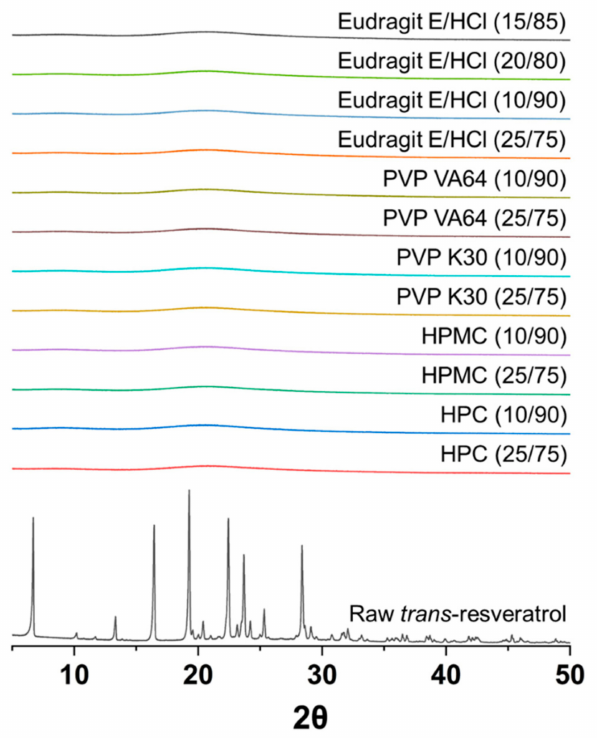
Figure 2. Powder X-ray diffraction patterns of raw trans -resveratrol and solid dispersion powders produced using the spray drying